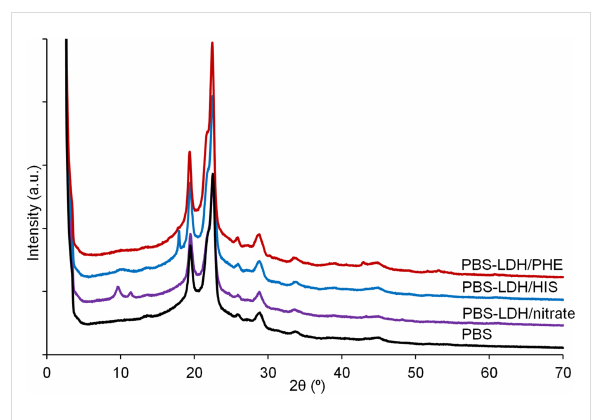
Figure 6: XRD patterns of PBS nanocomposites with 5 wt % Mg 2 Al LDH